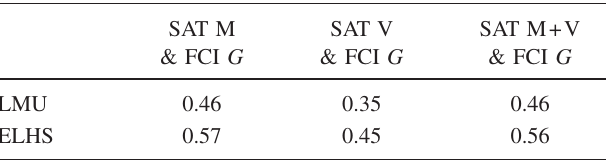
TABLE I. The correlations of math (cid:1) M (cid:2) , verbal (cid:1) V (cid:2) , and com- bined math and verbal (cid:1) M (cid:2) V (cid:2) SAT scores with FCI G .